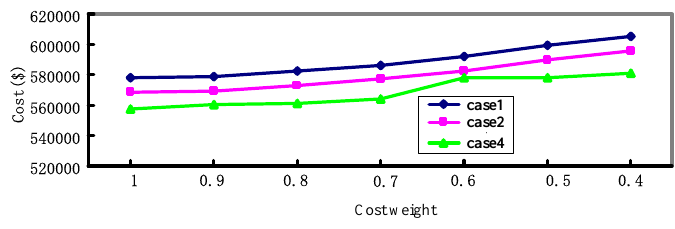
Figure 3. The influence of PHEVs on load curve in smart grid.